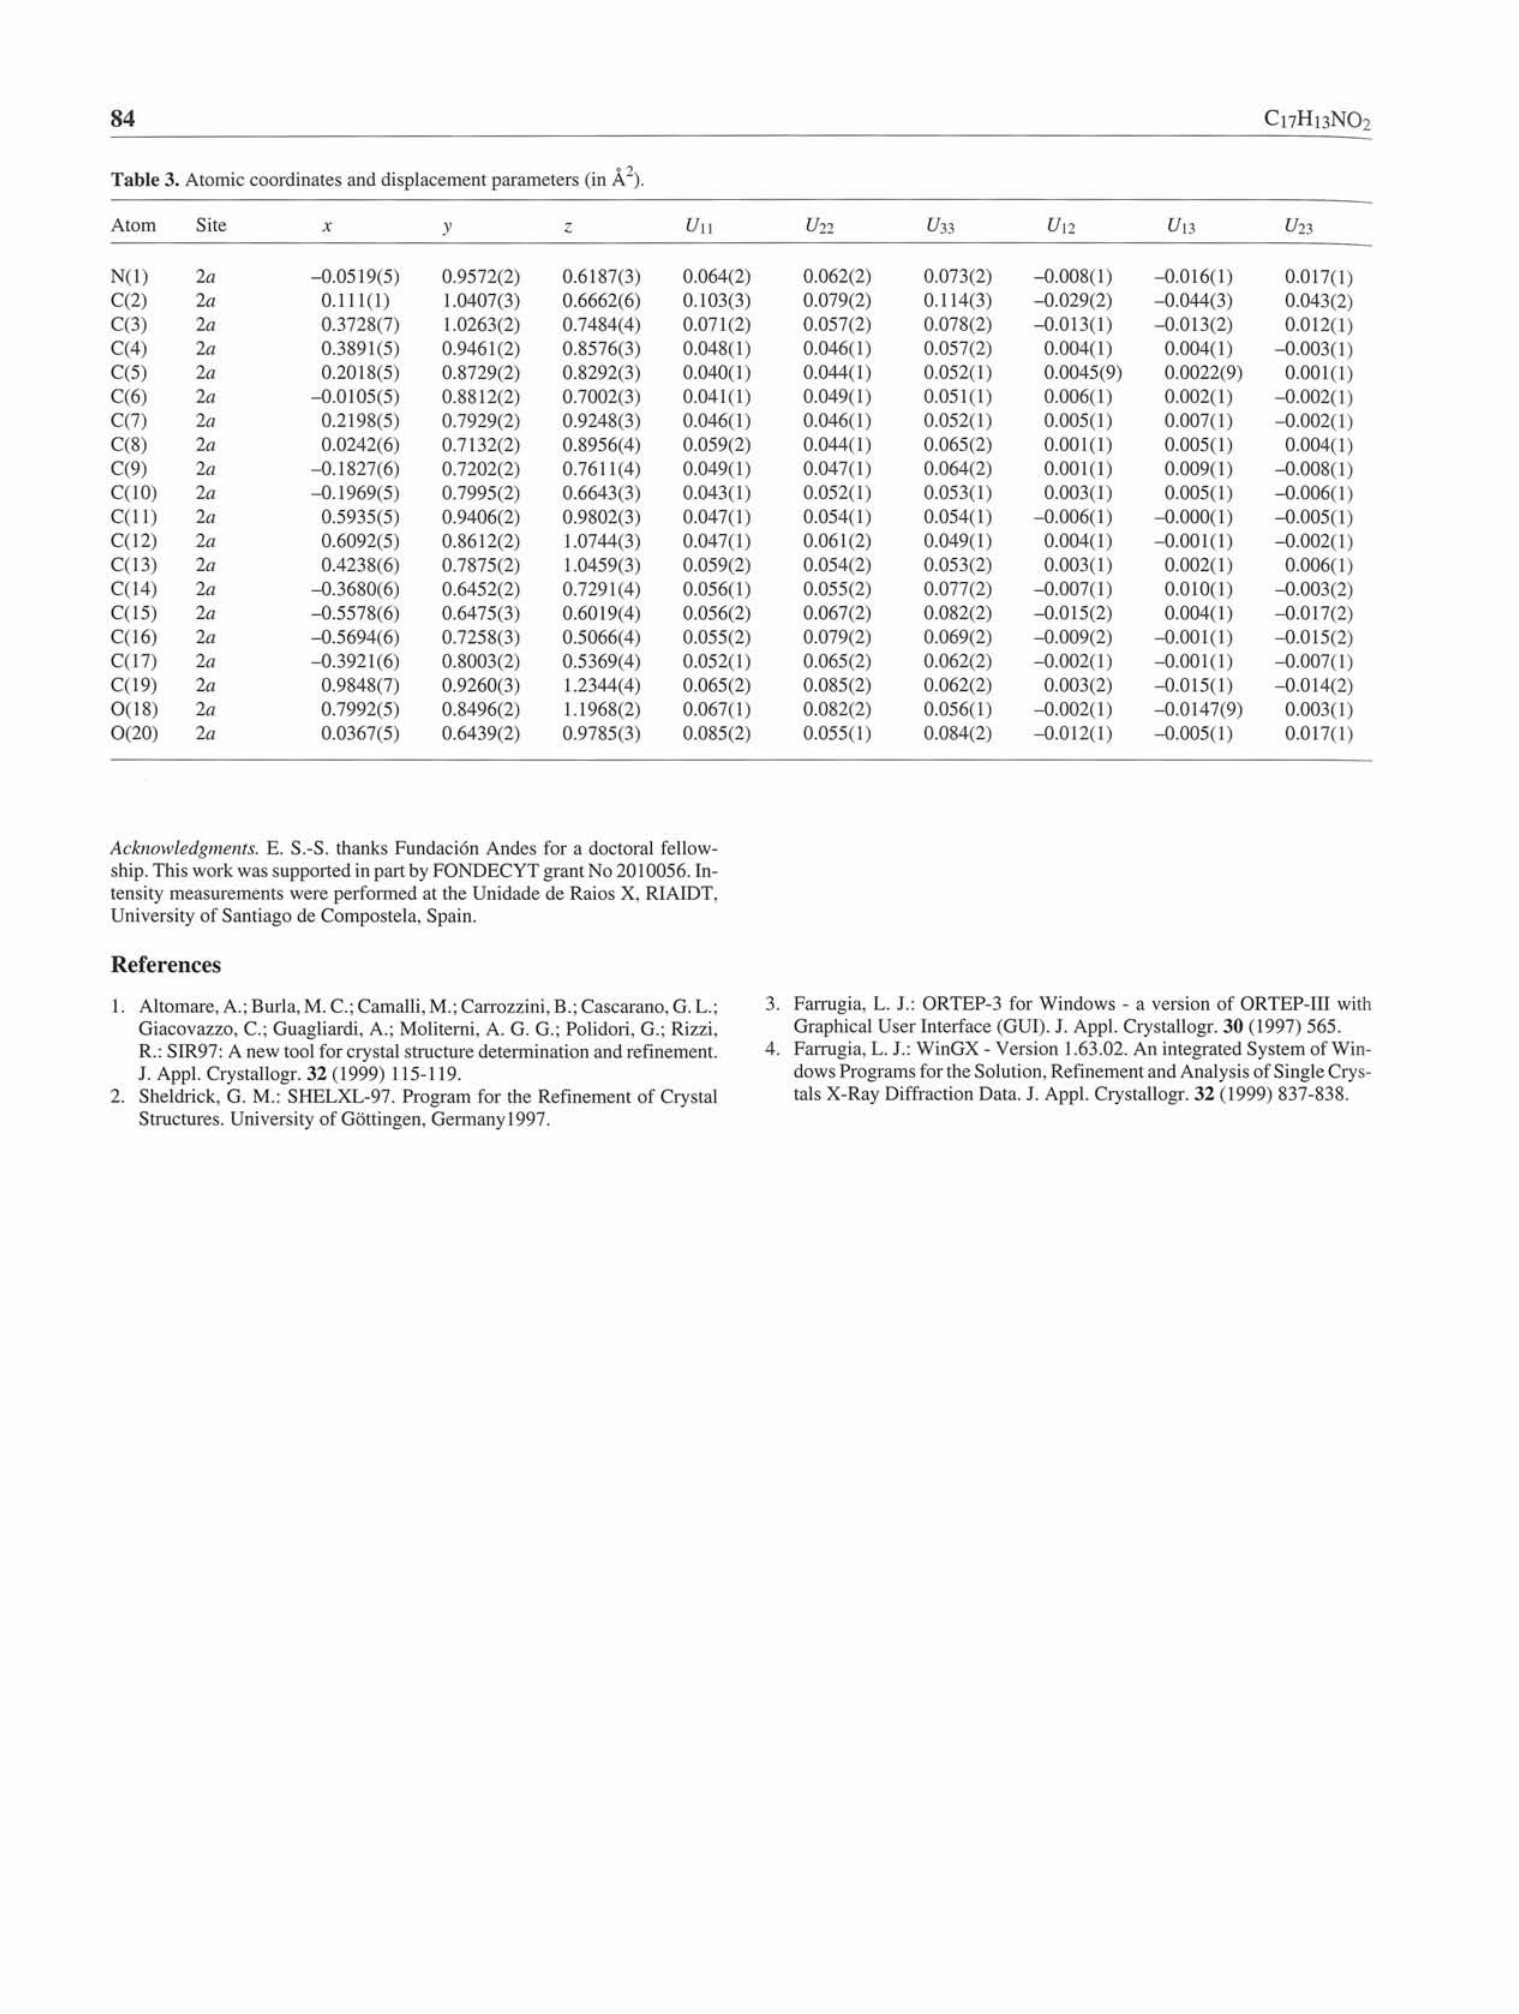
Table 3. Atomic coordinates and displacement parameters (in